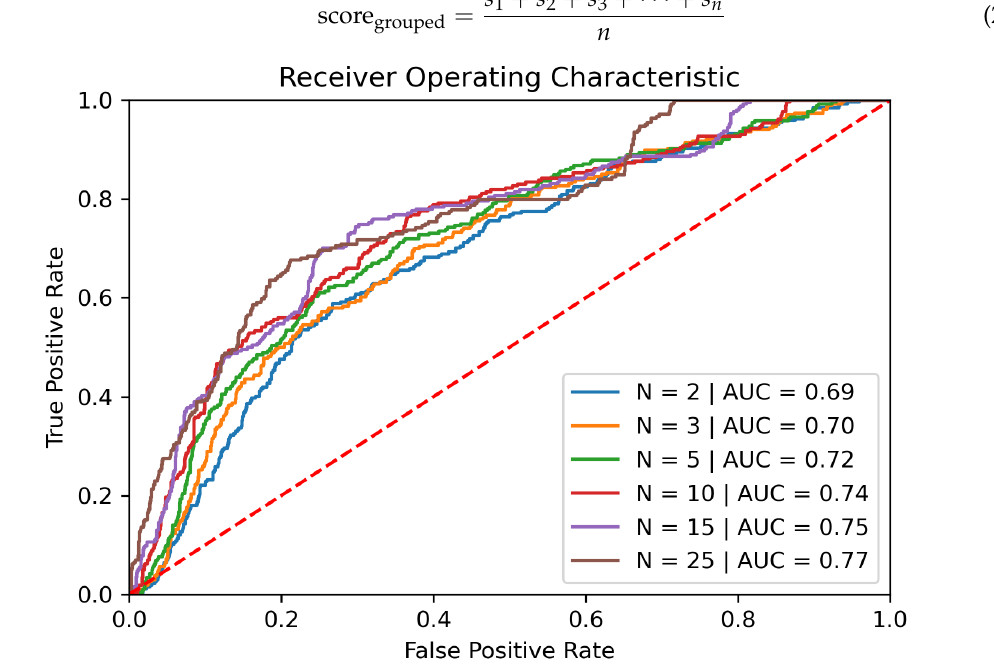
Figure 4. ROC multiple gestures for position data with all gesture lengths—3 hidden states and 2